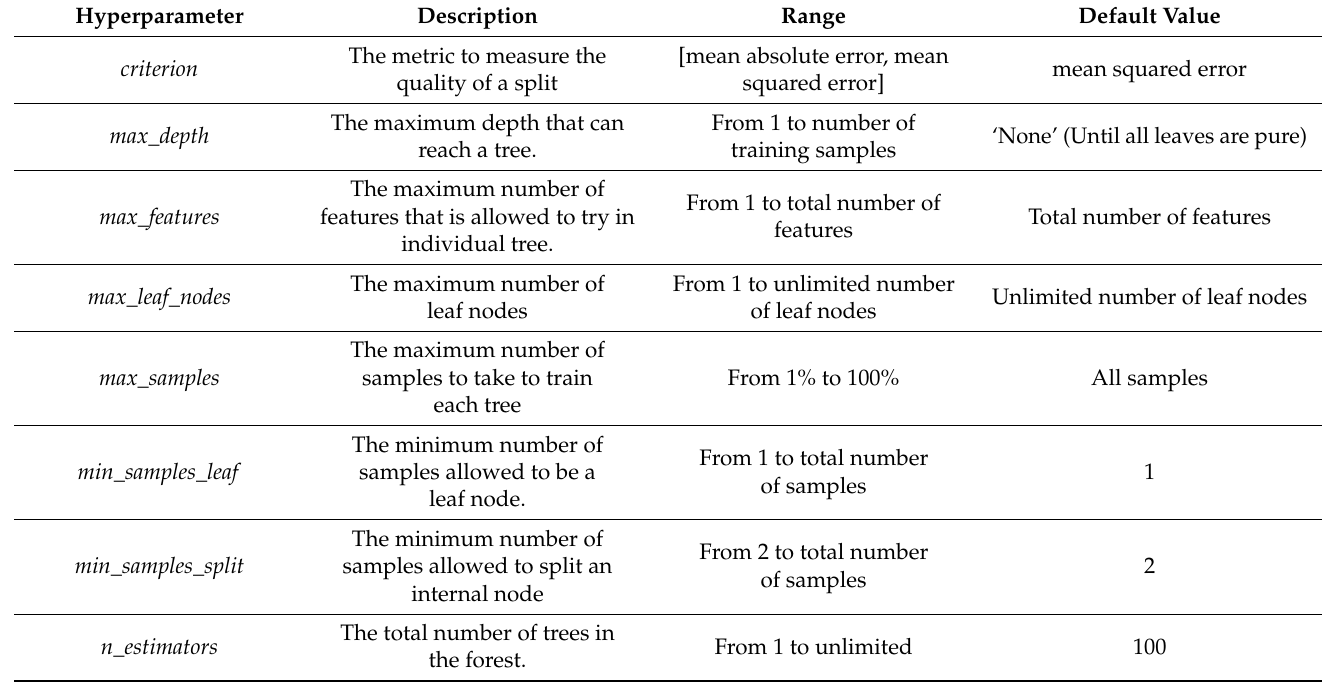
Table 1. Description of used